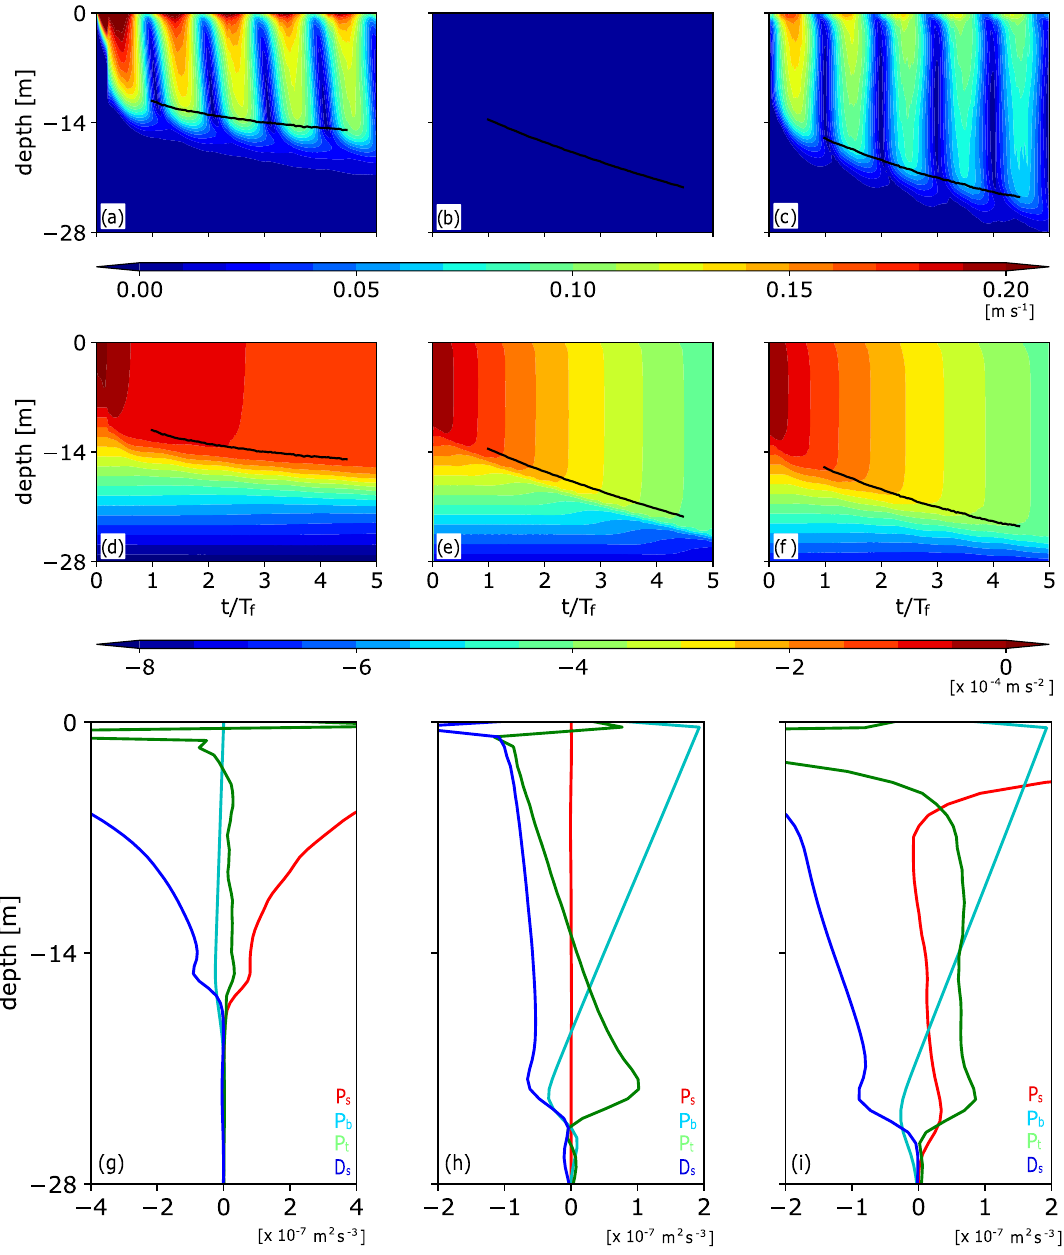
Figure 1. Time-depth variation of the horizontally averaged (a)–(c) current speed and (d)–(f) buoyancy ( B ) and (g)–(i) the vertical profiles of the TKE tendency terms averaged over 4.0 < t / T f < 5.0 in the (a), (d), (g) pure ST ( U 2 (c), (f), (i) coexisting ST and CT ( U 2 stratification and initial MLD are N 0 represent the